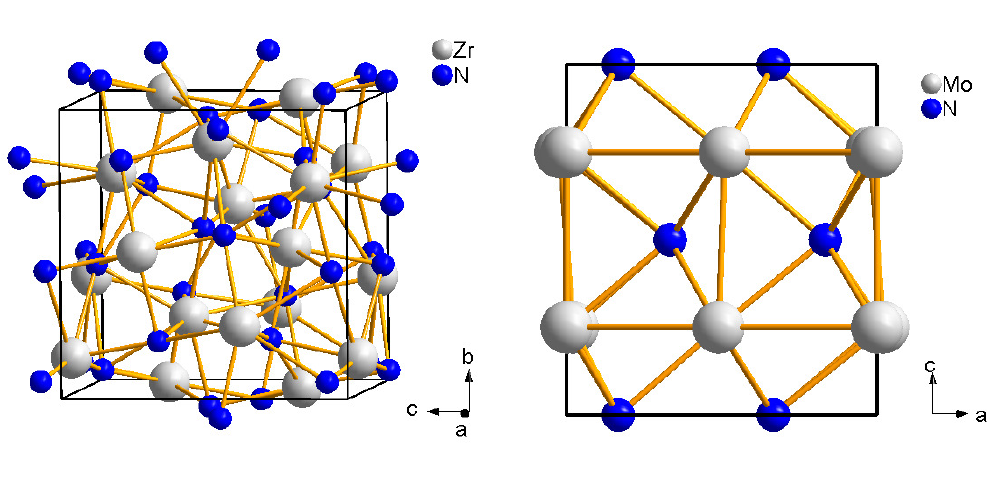
N ( I ¯43 d , left) consisting of edge-sharing ZrN 3 4 mc , right) 3